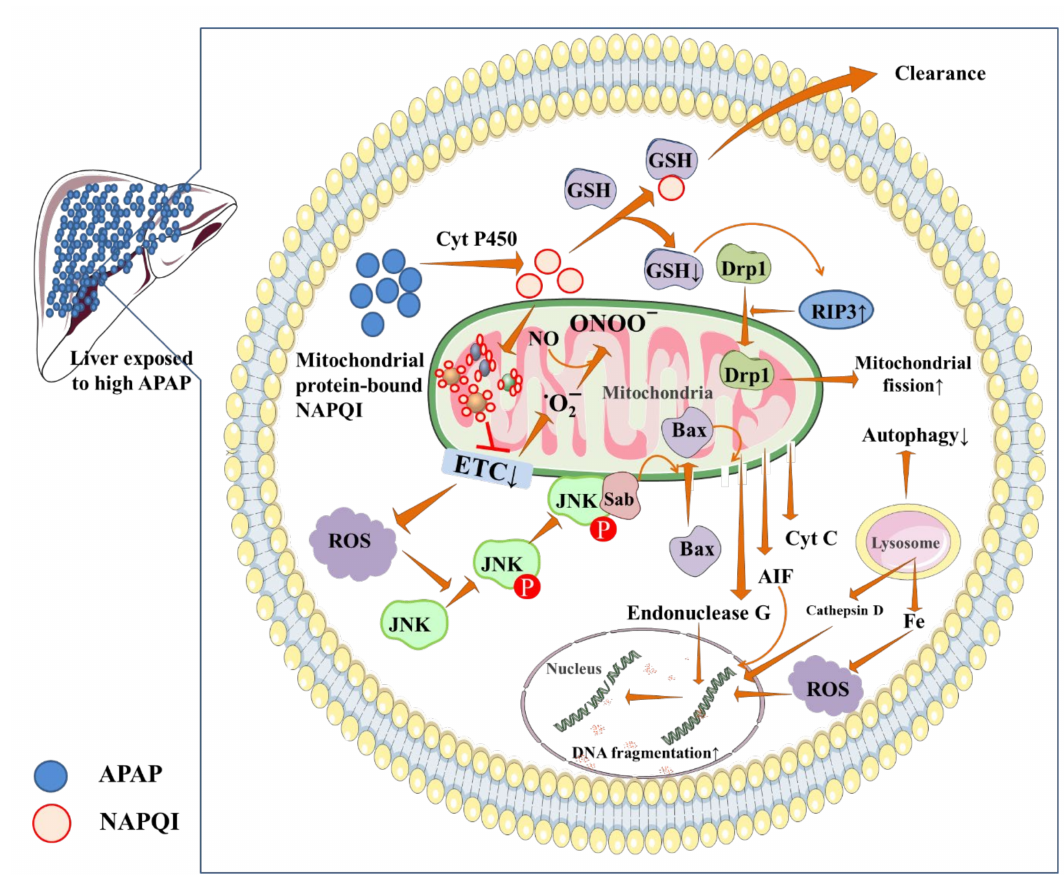
Figure 2. Mechanism of APAP-induced acute liver injury. In an acute overdose or frequent appli- cation of APAP, a greater amount of APAP is metabolized by CYP2E1 resulting in an enhanced NAPQI accumulation in the liver, which enhances the accumulation of ROS by depleting GSH and inhibiting the mitochondrial electron transport chain. ROS react with NO to produce RNS which, in collaboration with ROS, impart oxidative damage to liver cells. ROS also activate several pathologi- cal signal transductions. In addition, NAPQI-mediated release of lysosomal proteases potentiates hepatocellular necrosis and suppresses autophagy. Lysosomal iron release to the cytosol further triggers ROS production. Brown arrows represent downstream events. ‘ ↑ ’ represents upregulation and ‘ ↓ ’ represents downregulation. AIF: apoptosis-inducing factor, APAP: acetaminophen, Bax: Bcl-2 associated X, CYP2E1: cytochrome P450 2E1, Cyt C: cytochrome C, Drp1: dynamin-related